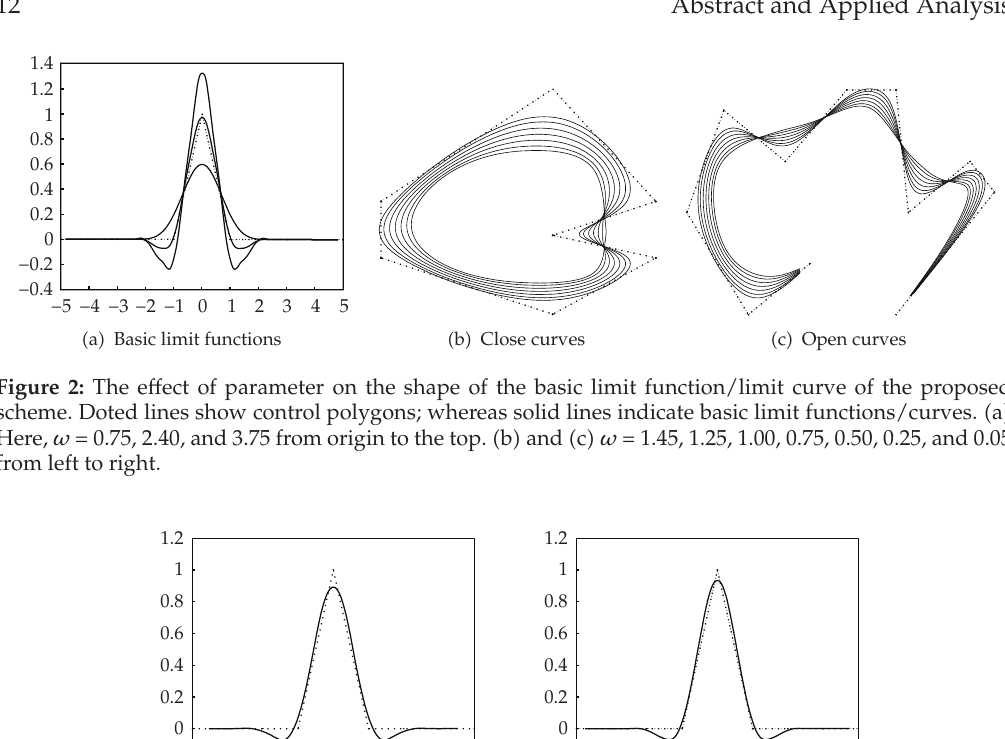
(cid:27) k − 1 1 / 4 j (cid:3) . So the total support width j (cid:8) 0